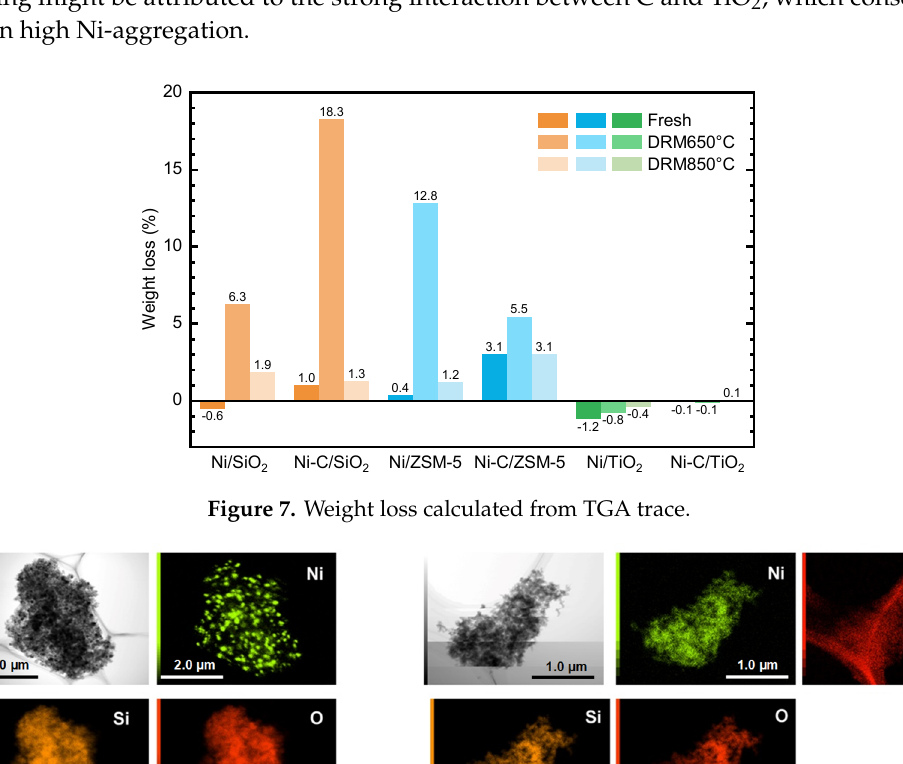
Figure 8. TEM-EDS elemental mapping images of fresh catalysts: ( a ) Ni/SiO 2 and ( b ) Ni-C/SiO 2 .